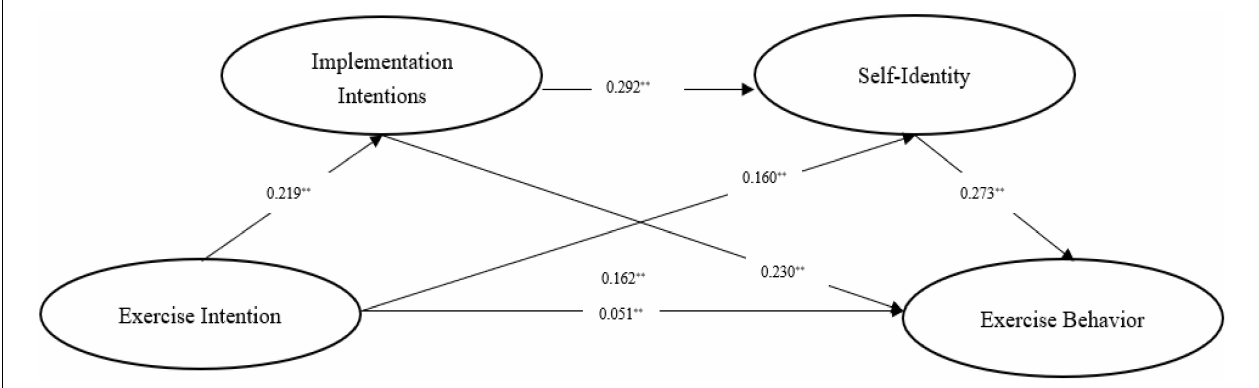
FIGURE 2 | Chain mediating model of implementation intention and self-identity in exercise intention and exercise behavior. ** p <